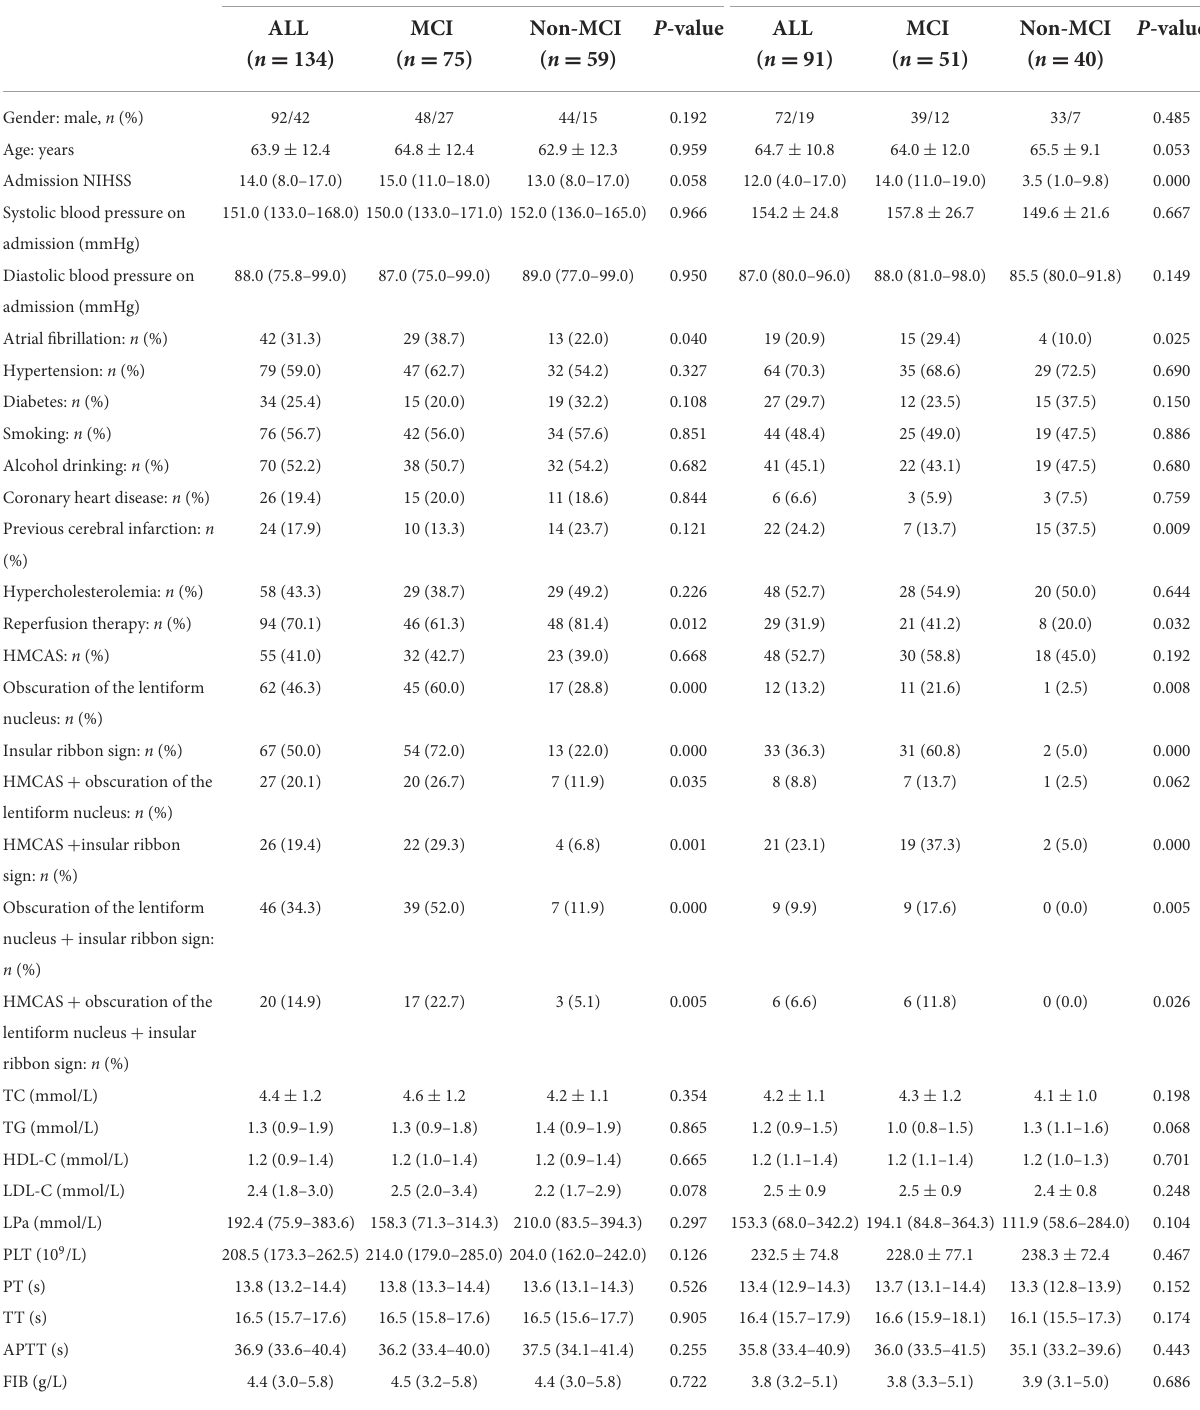
TABLE 1 General characteristics for development and validation